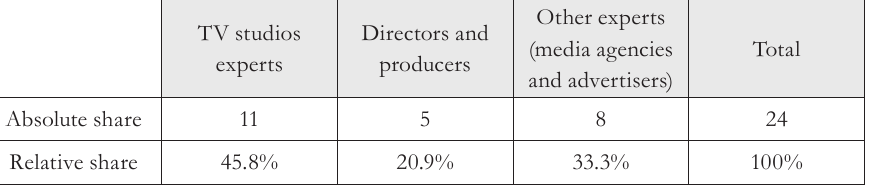
Tab. 1 – Target group characteristics. Source: